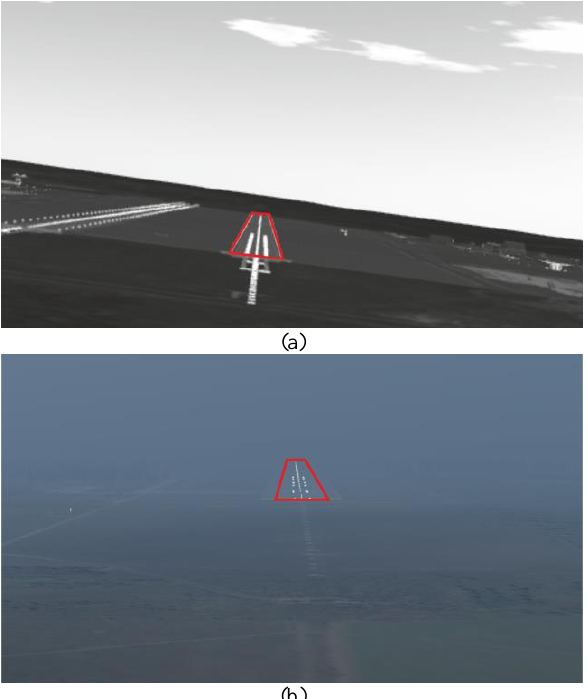
Figure 4. Examples of the runway detection in clear visible conditions (a) and in fog